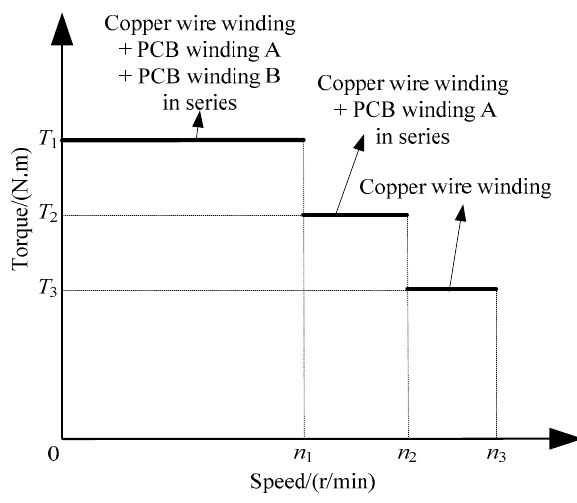
Figure 3. The DDPMIM ideal torque-speed curve.